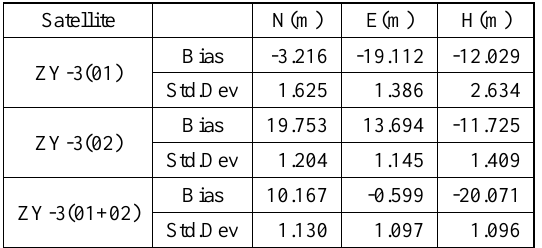
Table 2. The bias and the standard deviation of the ZY-3